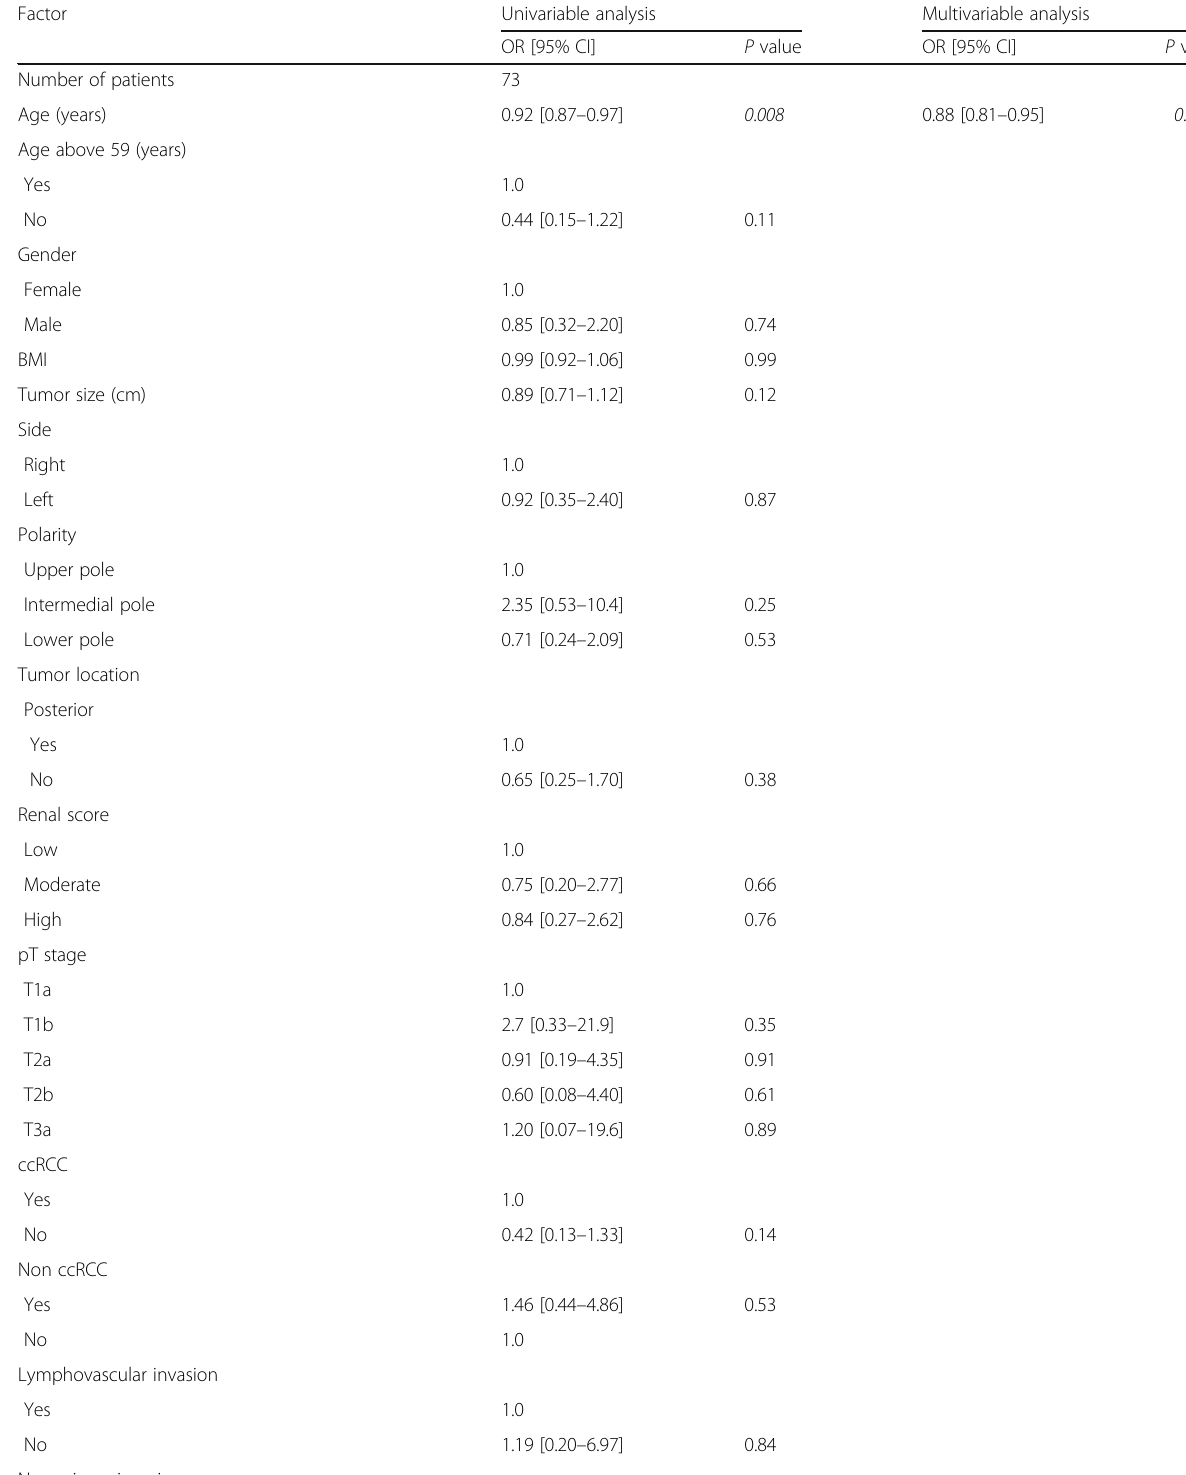
Table 1 Factors for visualization, univariable and multivariable